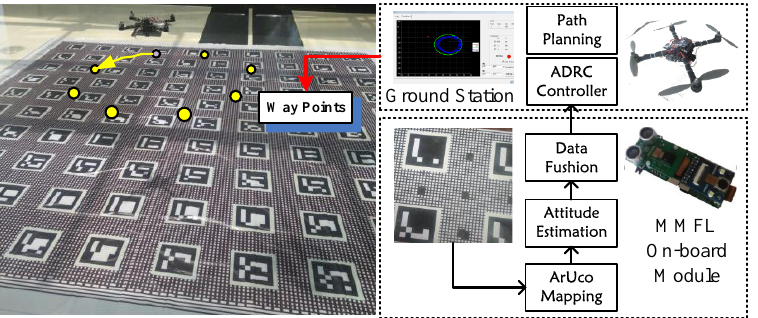
Figure 4. Experiment